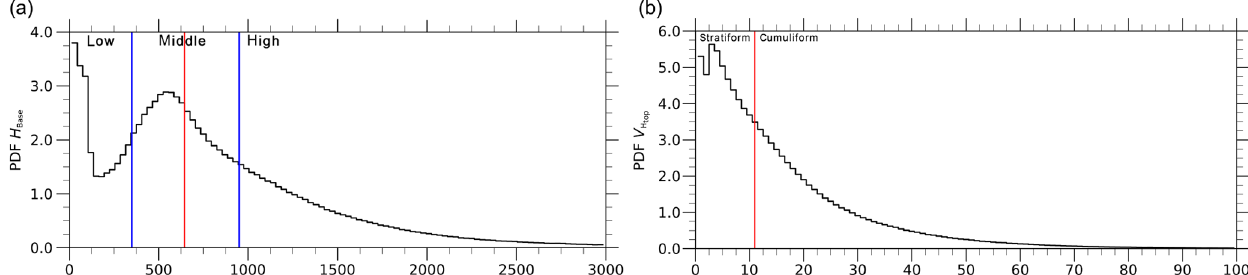
Figure 2. PDFs of the spatio-temporal distributions of (a) of cloud-base height (m) and (b) cloud-top height variability (%), for daily data for the 4-year period 2007–2010. The red lines indicate the median of the PDFs, and the two blue lines in (a) represent the borders of the cloud-base